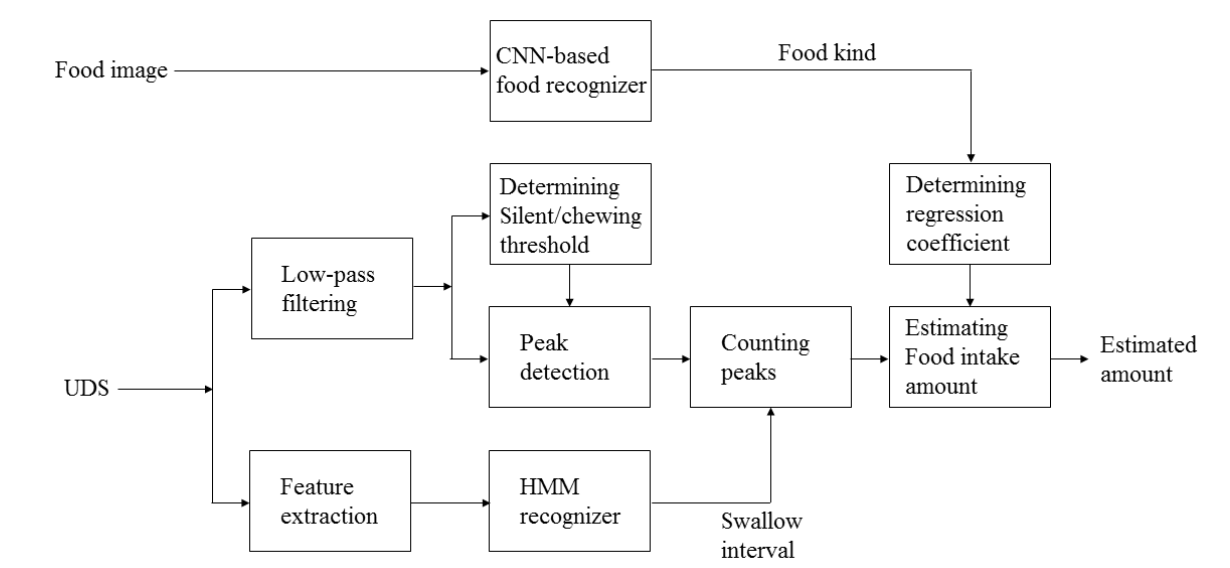
Figure 6. A block diagram of the proposed dual-modality food intake estimation